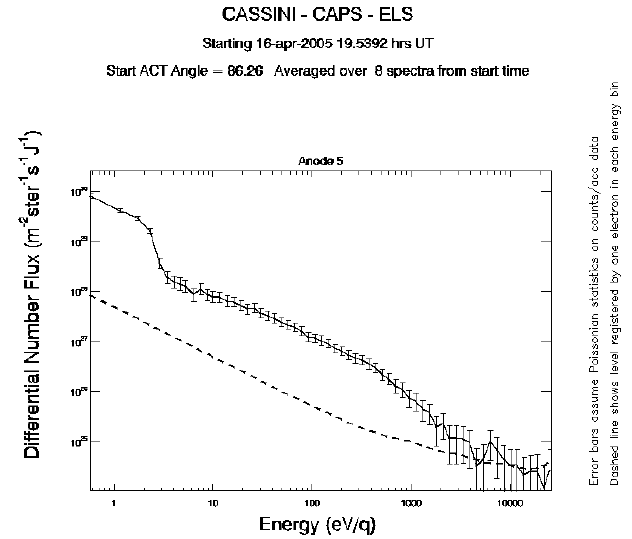
Fig. 10. CAPS/ELSdifferential electron fluxes in the magnetosphere. Data taken during the outbound trajec- Fig. 10. CAPS/ELS differential electron fluxes in the magneto- tory. AbroadenergyelectronpopulationbetweenafeweVand2000eVisdetected. Thespacecraftphotoelec- tronsareobservedbelow3eV. sphere. Data taken during the outbound trajectory. A broad energy electron population between a few eV and 2000eV is detected. The spacecraft photoelectrons are observed below